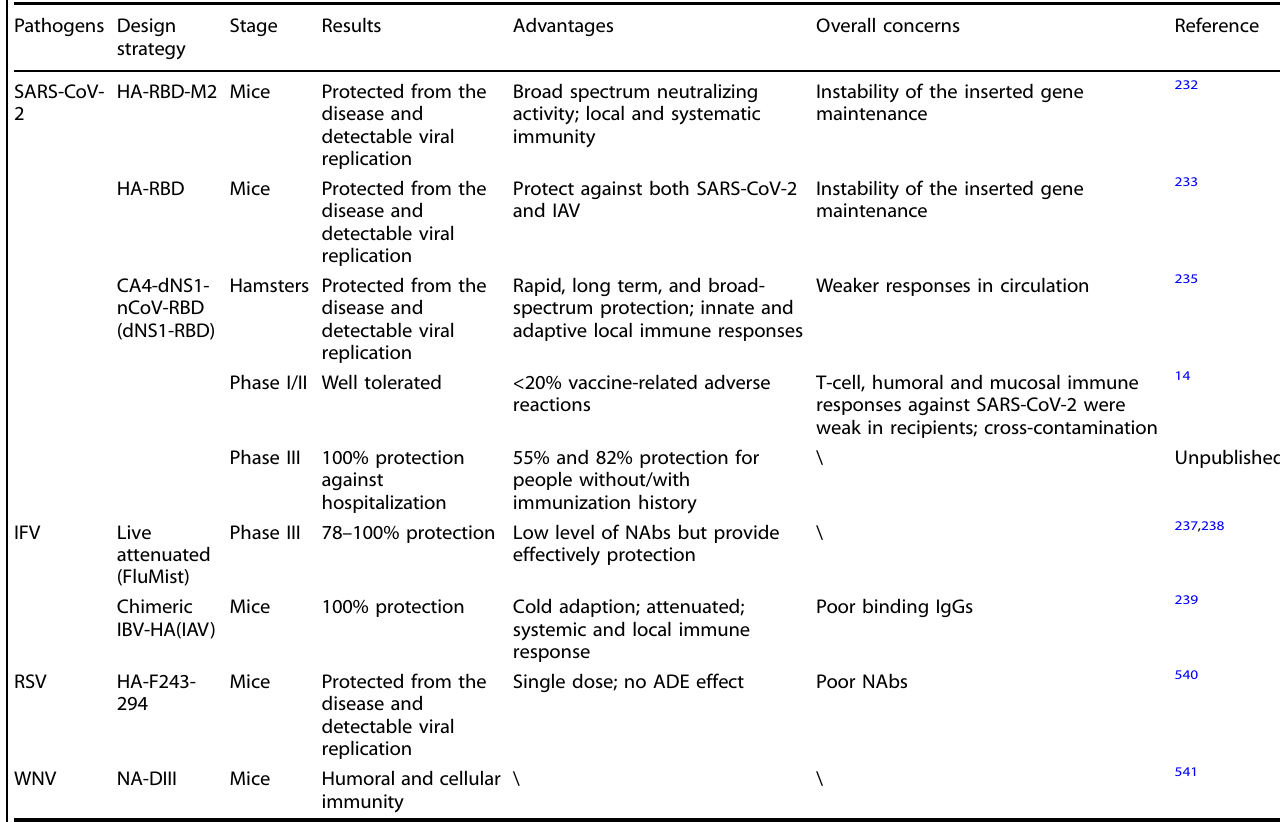
Table 7. Vaccines based on in fl uenza virus vector Pathogens Design strategy